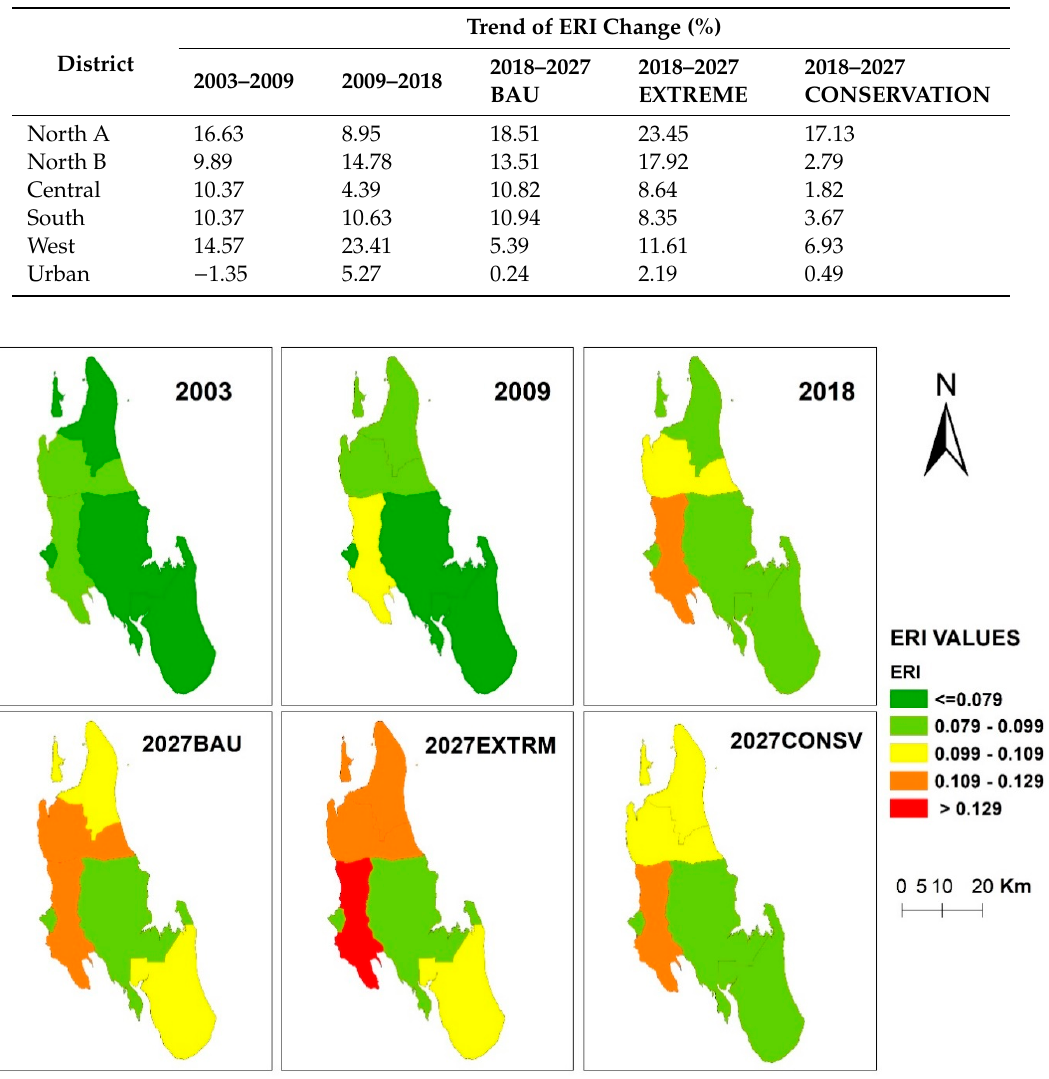
Table 13. Ecological Risk Index changes by district 2003–2027.